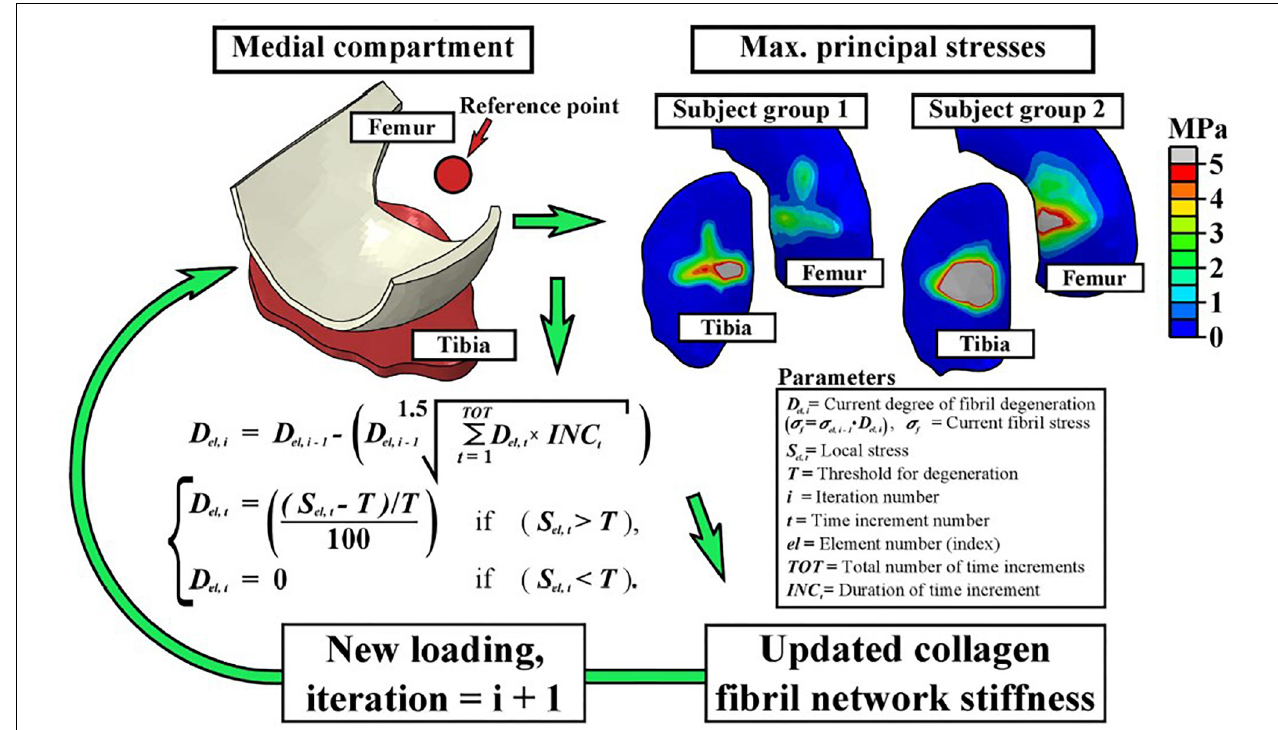
FIGURE 3 | The fibril degeneration algorithm (shown in the left side) was based on excessive maximum principal stresses in the medial compartment of the knee joint. The stress distributions on the right are obtained at the first peak loading force of the stance phase of gait. The model was run iteratively to simulate gradual degeneration of the collagen fibril network (Mononen et al.,